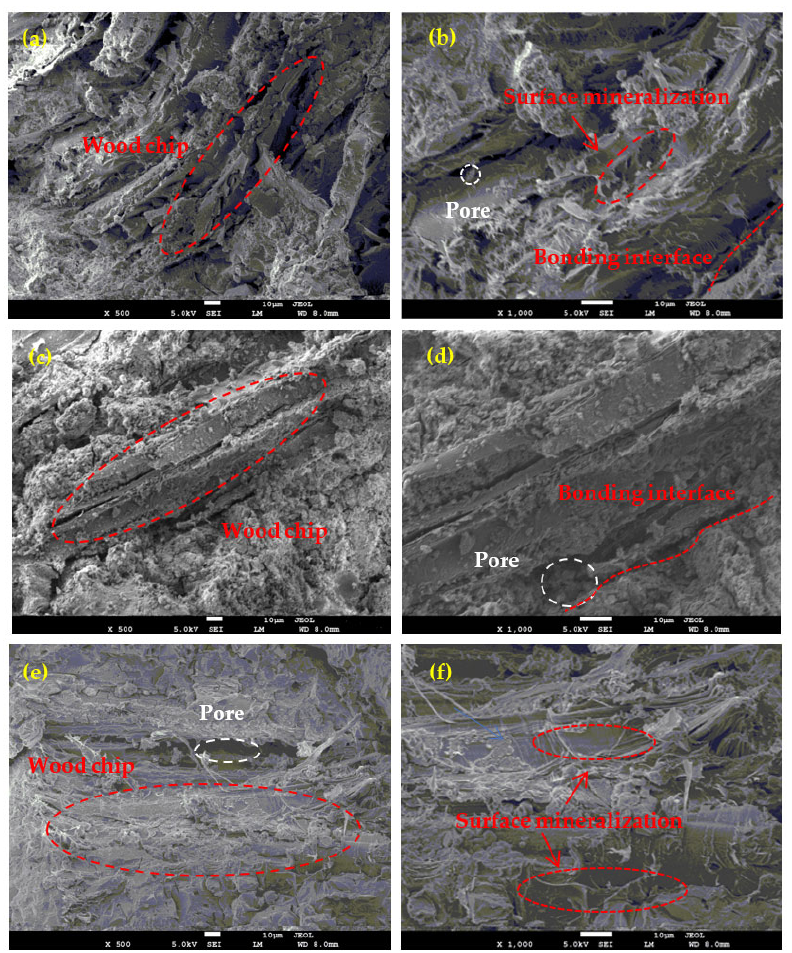
Figure 6. SEM of wood chip lightweight cementitious composites: ( a ) OPC 500 times; ( b ) OPC 1000 times; ( c ) SAC 500 times; ( d ) SAC 1000 times; ( e ) GBFS 500 times; ( f ) GBFS 1000 times.